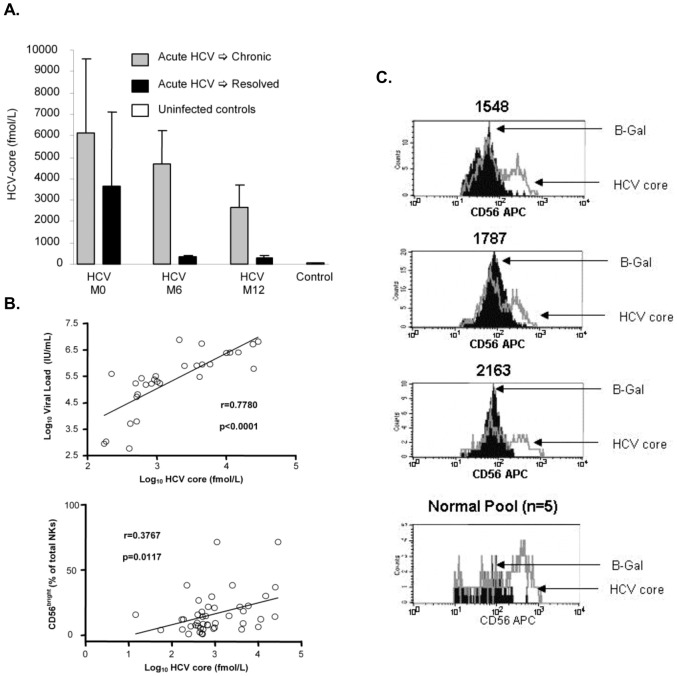
Circulating HCV-core levels in acute HCV infection and effect of extracellular core on NK cell CD56 expression.Circulating HCV-core protein levels as measured by ELISA (A). As expected, core levels correlated directly with viral levels in HCV-infected patients. There was also a direct statistically significant correlation between core and the levels of CD56bright NK cells in these patients. Multiple time points were used for chronic patients (B). Incubation of highly purified FACS sorted CD56bright NK cells, from normal uninfected control subjects, in the presence of HCV-core or beta-galactosidase (β-Gal) control protein demonstrated inhibition of CD56 down-regulation by exogenous HCV-core protein. Histograms of CD56 expression levels after incubation are shown for four individual experiments (C). The first three histograms represent individual normal control subjects and the fourth histogram is derived from an experiment in which PBMCs from five normal uninfected control subjects were pooled prior to sorting on CD56bright NK cells and incubation with HCV-core.